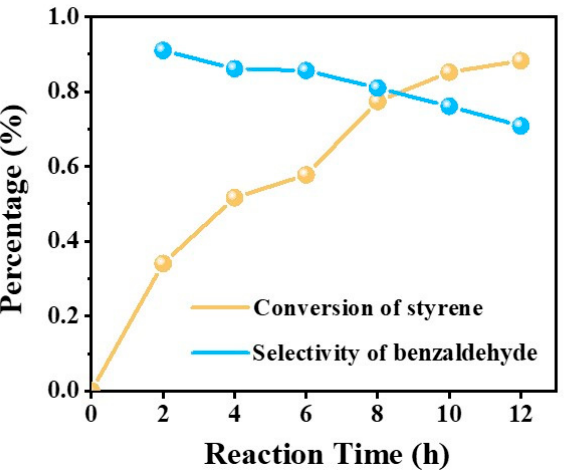
Figure 4. The catalytic performance versus reaction time over Cu 2 O@Cu-BDC-NH 2 -8h. Table 1. Compared catalytic performance of styrene oxidation with H 2 O 2 as the oxidants and a base-free condition over different catalysts.